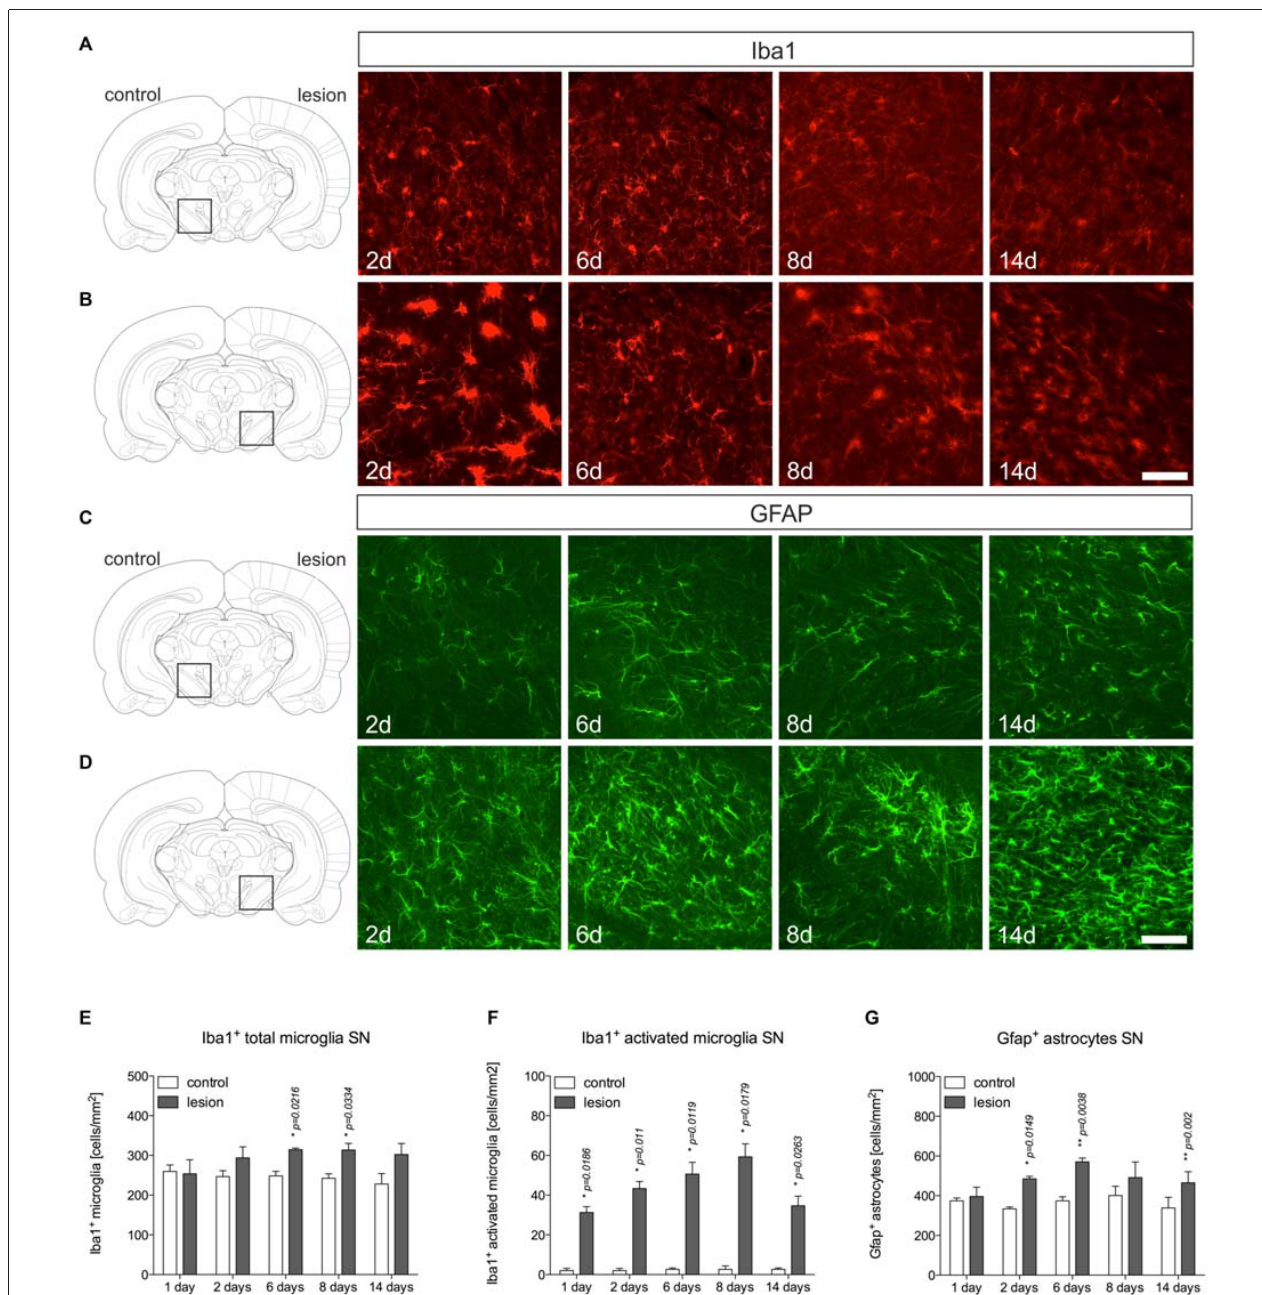
FIGURE 2 | Microglia and astroglia reactivity in the SN after 6-OHDA injections. On the control side microglia showing ramified morphologies could be detected by Iba1-immunohistochemistry at all time-points analyzed (A) . Two days after 6-OHDA injections, a strong microglia reactivity was observed on the lesioned side. After 6 days, microglia start to adopt a ramified morphology indicating that microglia reactivity is rapidly inhibited (B) . Immunohistochemistry for Gfap demonstrated the presence of Gfap + astrocytes in the SN on the control side at all time-points analyzed (C) . However, strong increases in Gfap-immunoreactivity and numbers of Gfap + astrocytes were observed starting from 6 days after injection of 6-OHDA and persisting until 14 days (D) . Scale bars indicate 75 µ m. Quantifications of total microglia (E) , activated microglia (F) and Gfap + astrocytes (G) in the SN on control and lesioned sides. Data are given as numbers/mm 2 (mean ± SEM) from three animals per time-point. p -values derived from student’s t -test are ∗ p < 0.05 and ∗∗ p <